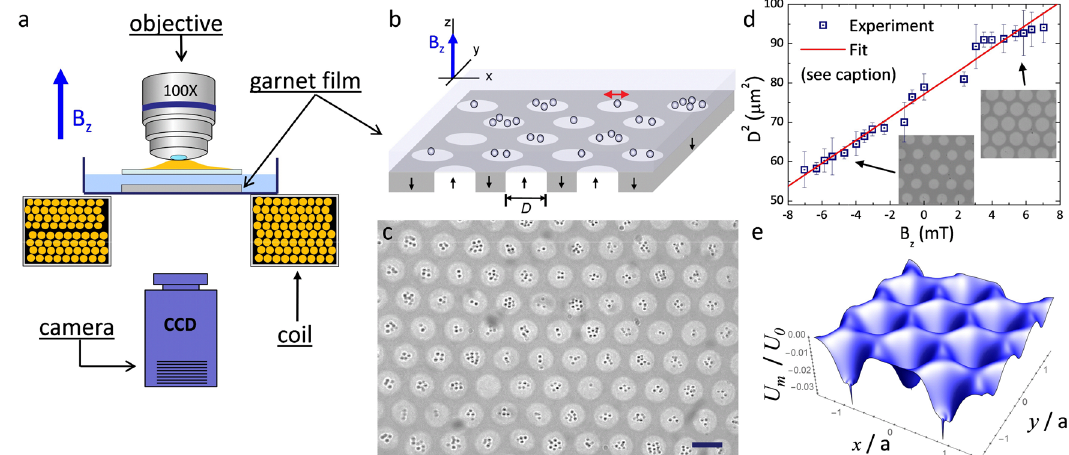
Fig. 1 Magnetic bubble lattice. a Schematic of the experimental setup used to visualize and control the Ferrite Garnet Film (FGF). b Detailed sketch of the FGF with magnetic bubble domains fi lled by different numbers of paramagnetic nanoparticles. The external magnetic fi eld B ext ¼ B z ^ z is applied perpendicular to the fi lm ( z axis). c Polarization microscope image of trapped nanoparticles (of diameter d = 360 nm). The magnetic bubble domains are visible due to the polar Faraday effect. Scale bar is 10 μ m, see also VideoS1 in the Supporting Information. d Square of the bubble diameter D 2 versus applied fi eld B z . Scattered points are experimental data while continuous line is a linear fi t according to D 2 ¼ 4 a 2 ½ð B z = B s þ 1 Þ sin ð π = 3 Þ = ð 2 π Þ(cid:3) (see “ Methods ” ), from which we extract the lattice constant a = 11.81 ± 0.02 μ m and the saturation magnetization B = 21.3 ± 0.3 mT. Error bars in D 2 are s obtained from the statistical average of different measurments. Insets show images of the magnetic domains. e Three-dimensional view of the magnetostatic potential U 1 calculated at an elevation z = 1.3 μ m and for B z = 0 mT. The ( x , z ) positions are rescaled by a , while the potential U 1 is rescaled